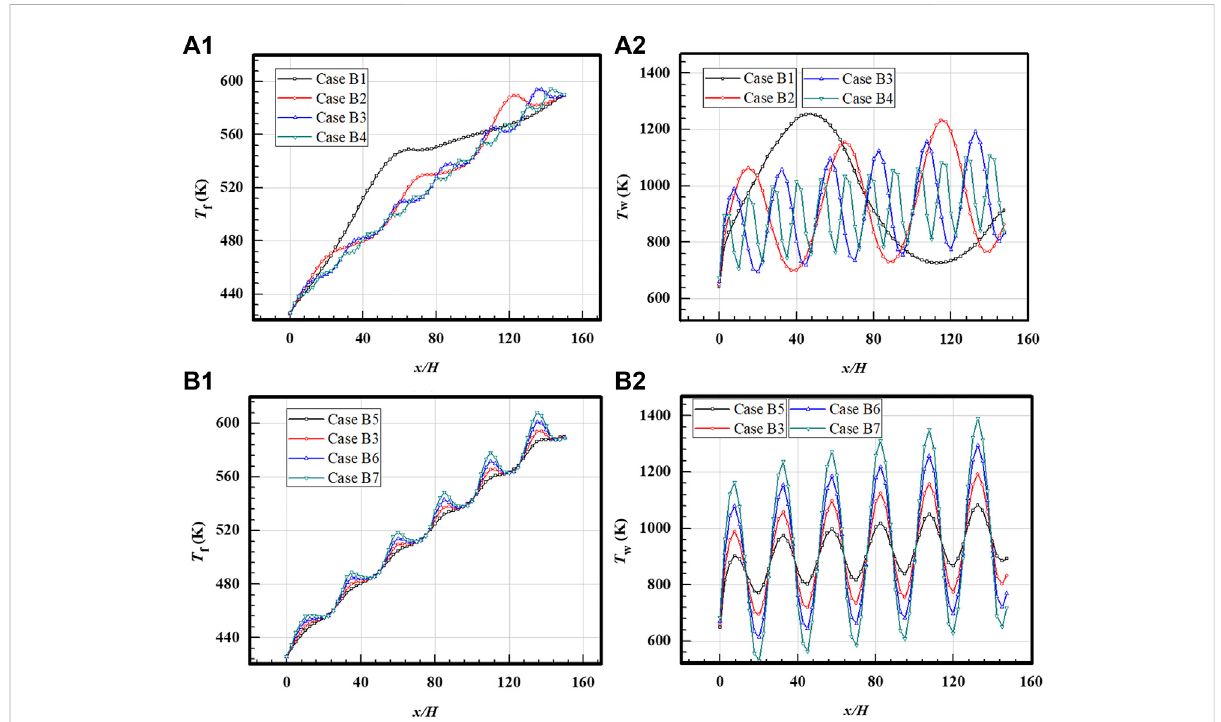
FIGURE 10 Temperature distributions for cases loaded with sinusoidal distributions. (A1) Fluid temperature for cases with different cycles. (A2) Averaged wall temperature for cases with different cycles. (B1) Fluid temperature for cases with different amplitudes. (B2) Wall temperature for cases with different